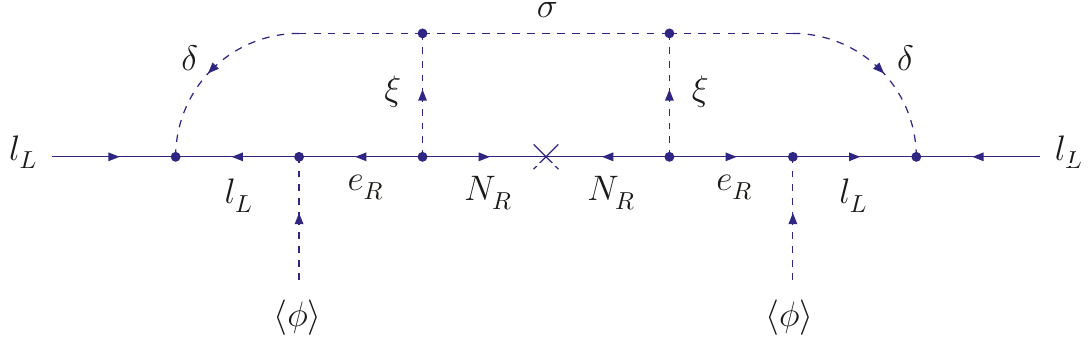
Figure 1 . The three-loop diagram for neutrino mass